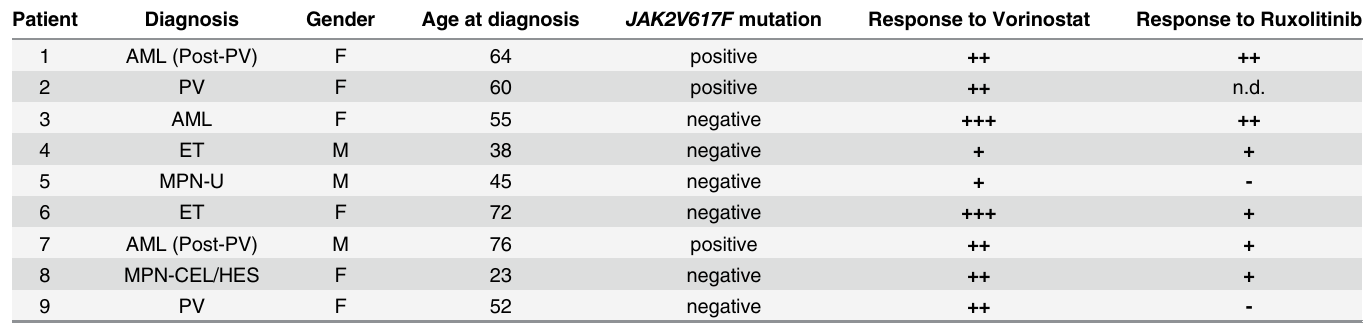
Table 1. MPN Patient